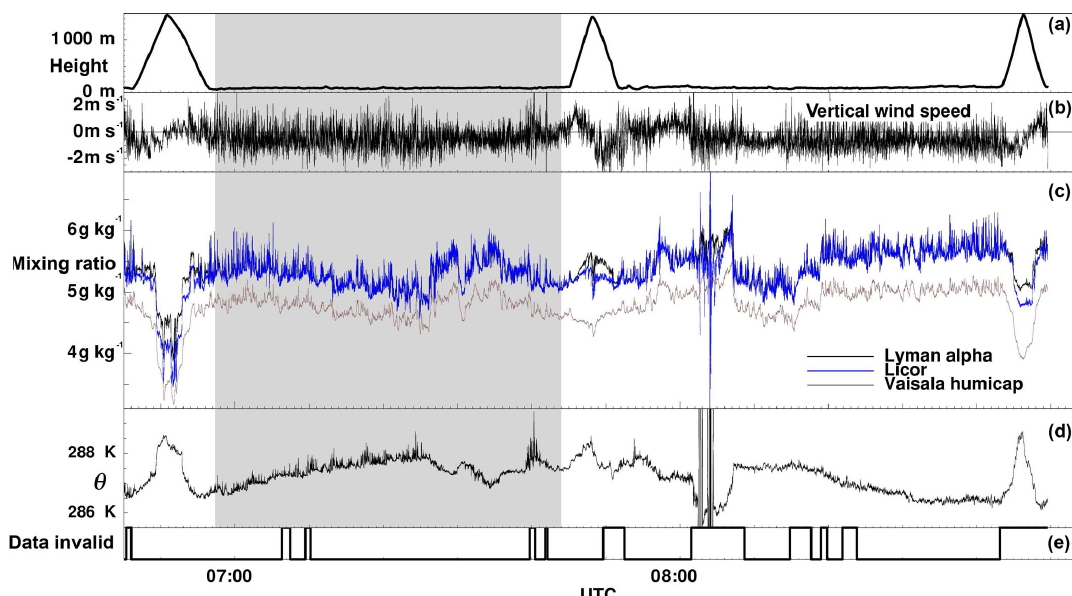
Figure 5. Overview of the flight with the Helipod on 14 August 2014. Panel (a) shows the height and (b) the vertical wind speed, indicating the strength of atmospheric turbulence. Panel (c) shows the time series of the mixing ratio measured by Lyman-alpha (black), Vaisala Humicap (purple) and the open-path Li3 (blue). Panel (d) represents the potential temperature. Panel (e) shows the parts of the flight with data that were excluded from the analysis for various reasons (e.g. impact of rain). For the spectral analysis, the part of the data shaded in grey was used, excluding segments indicated in the lowermost panel.